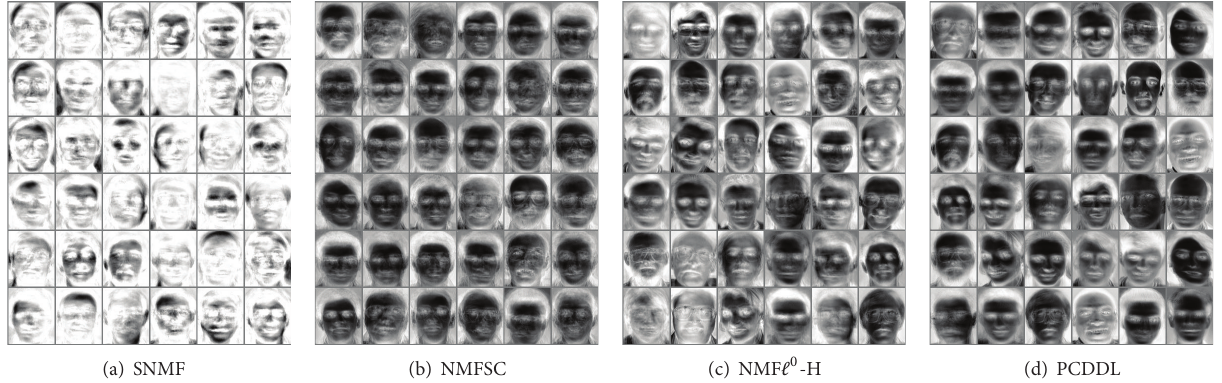
Figure 10: Globally featured faces learned by SNMF, NMFSC, NMF ℓ 0 -H, and PCDDL.